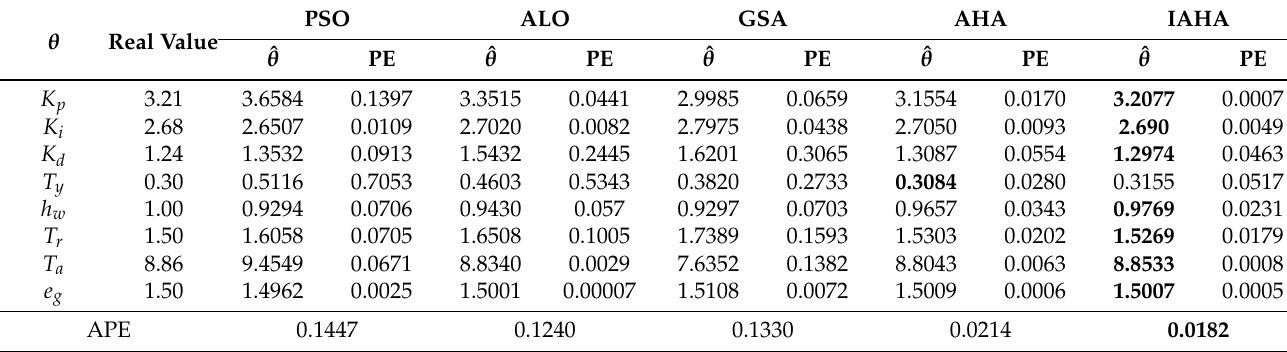
Table 6. Algorithm identification results of 10% frequency